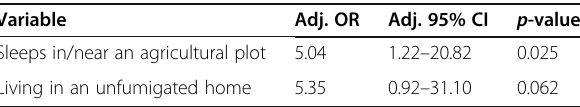
Table 2 Adjusted odds ratios (OR) and their 95% confidence intervals (95% CI) for the association between Leishmania spp.